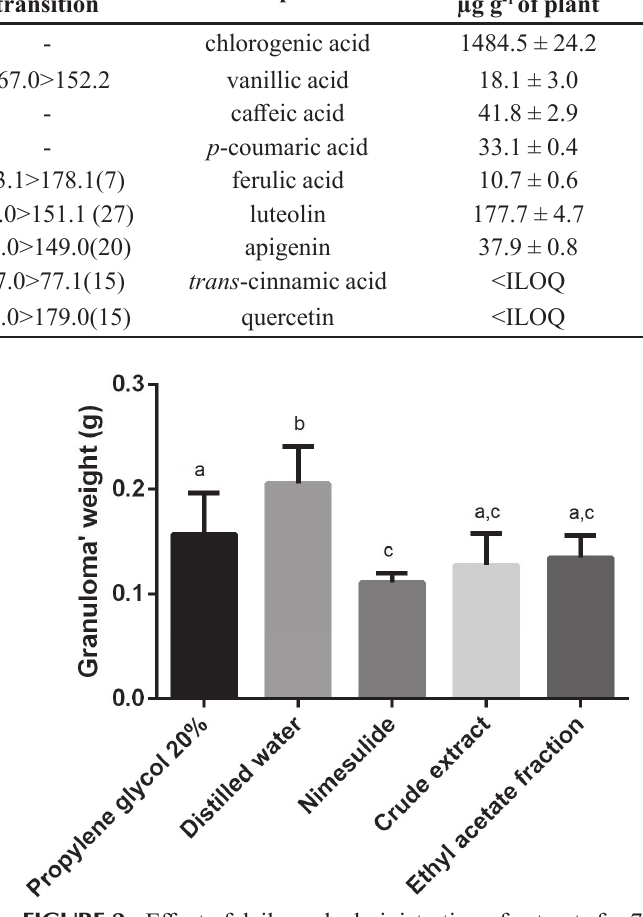
FIGURE 2 - Effect of daily oral administration of extracts for 7 days on the granulomatous tissue formation. The bar represents the mean ± S.D. of six rats. Means identified by the same letter do not differ statistically. TABLE II - Liver, kidney and pancreas damage markers obtained from animal serum after treatment through the administration of the crude extract and the ethyl acetate fraction of V. litoralis PR H O N EB FA 2 AST